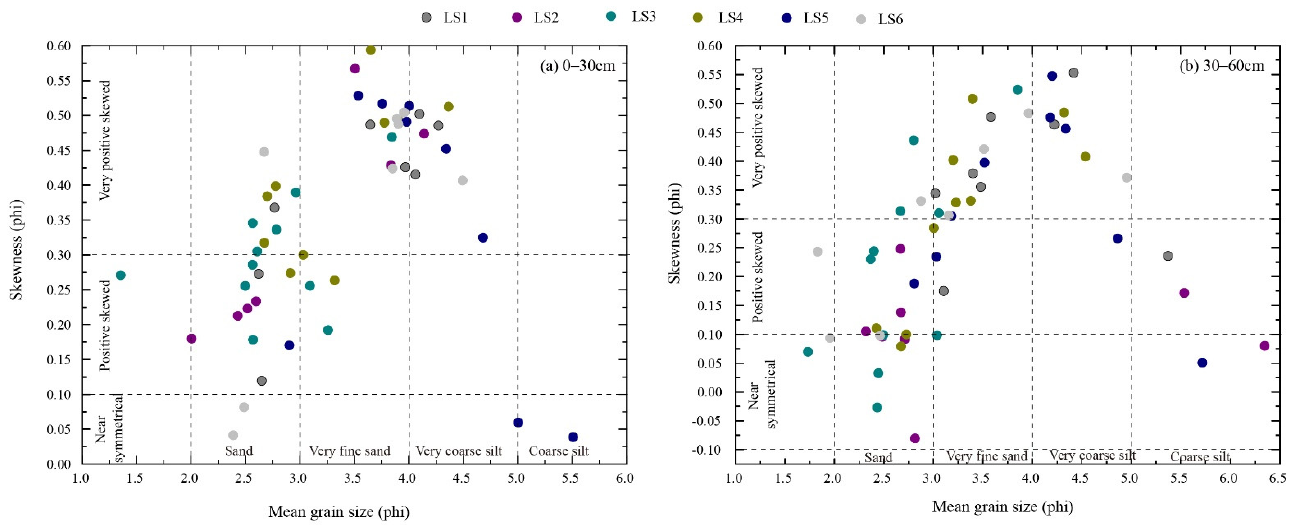
Figure 6. Correlations between mean grain size (Mz) and skewness (SK I ) of the sediments collected from different land- scapes.